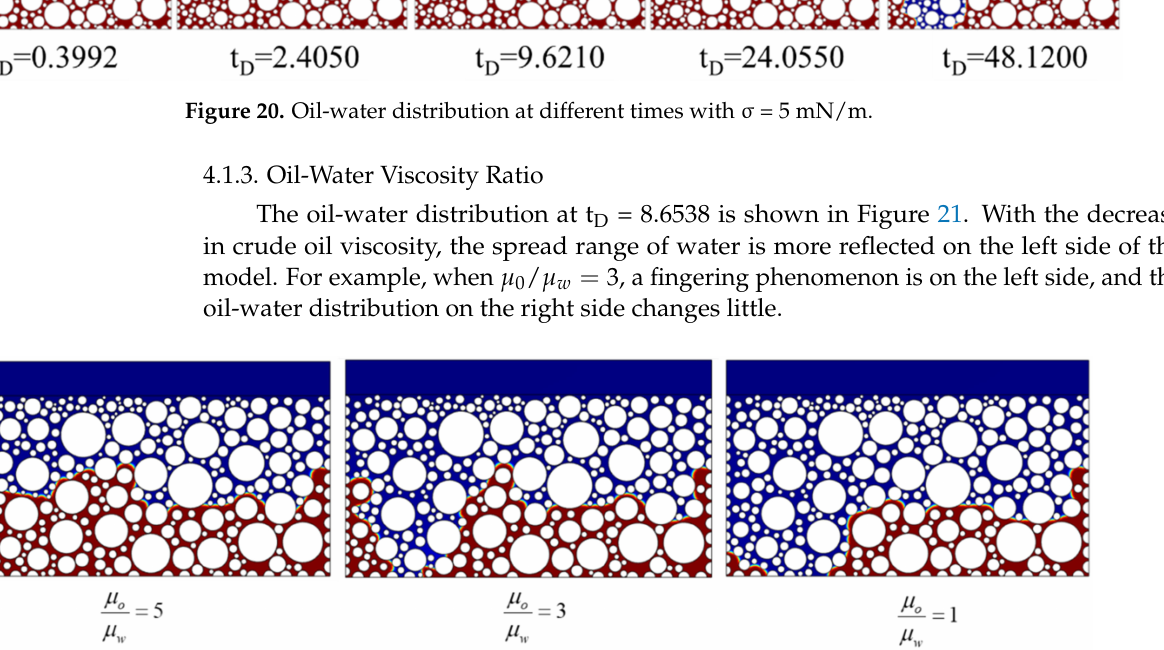
Figure 21. Oil-water distribution at the end of imbibition with different oil-water viscosity